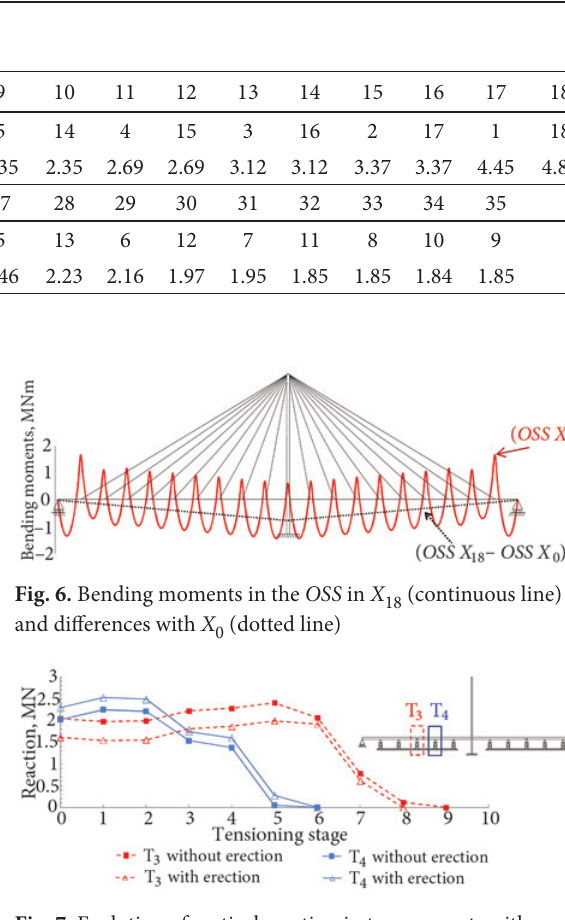
fig. 7. Evolution of vertical reaction in two supports